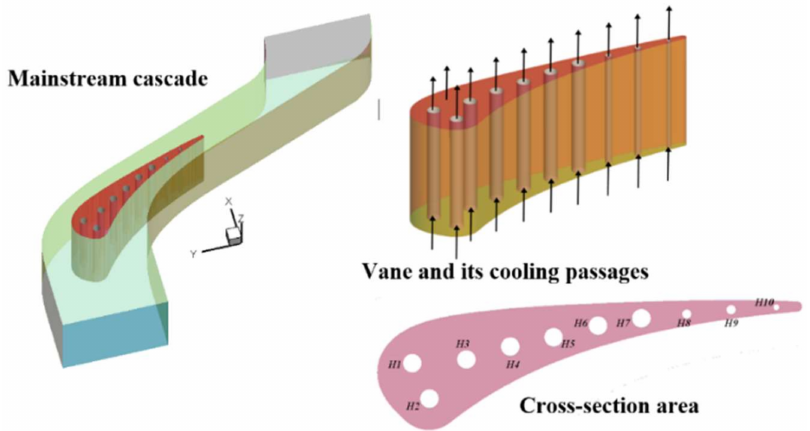
Figure 2. Mainstream cascade and C3X geometric configuration and its cross-section area at